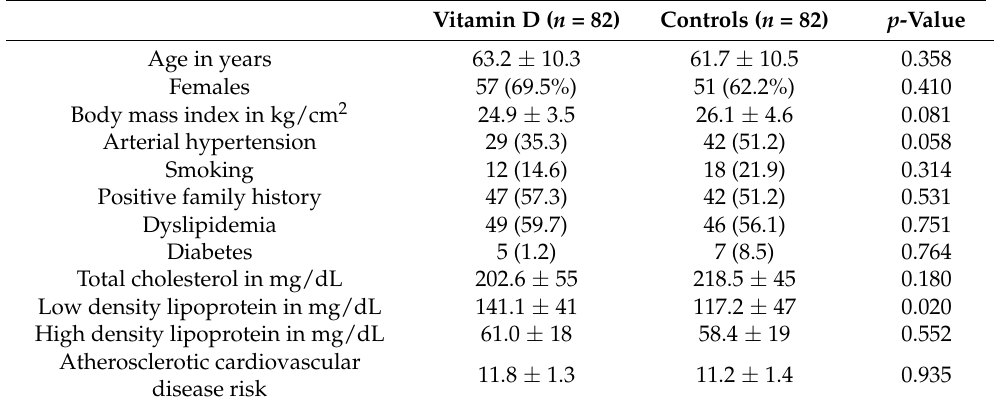
Table 1. Baseline characteristics after propensity score matchmaking. Parametric data are shown as means ± SD, ordinal data as counts ( n ) and percentage